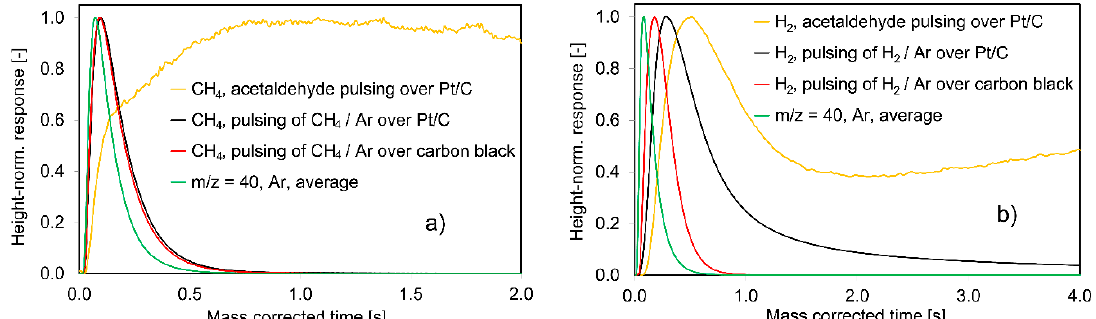
Figure 6. Height-normalized transient responses of CH 4 and H 2 , respectively, at 200 °C to: ( a ) pulses of 38.6 vol % acetaldehyde in Ar and 50 vol % CH 4 in Ar over H 2 pre-reduced Pt / C and over carbon black; ( b ) pulses of 38.6 vo l% acetaldehyde in Ar and 50 vol % H 2 in Ar over H 2 pre-reduced Pt / C and over carbon black.